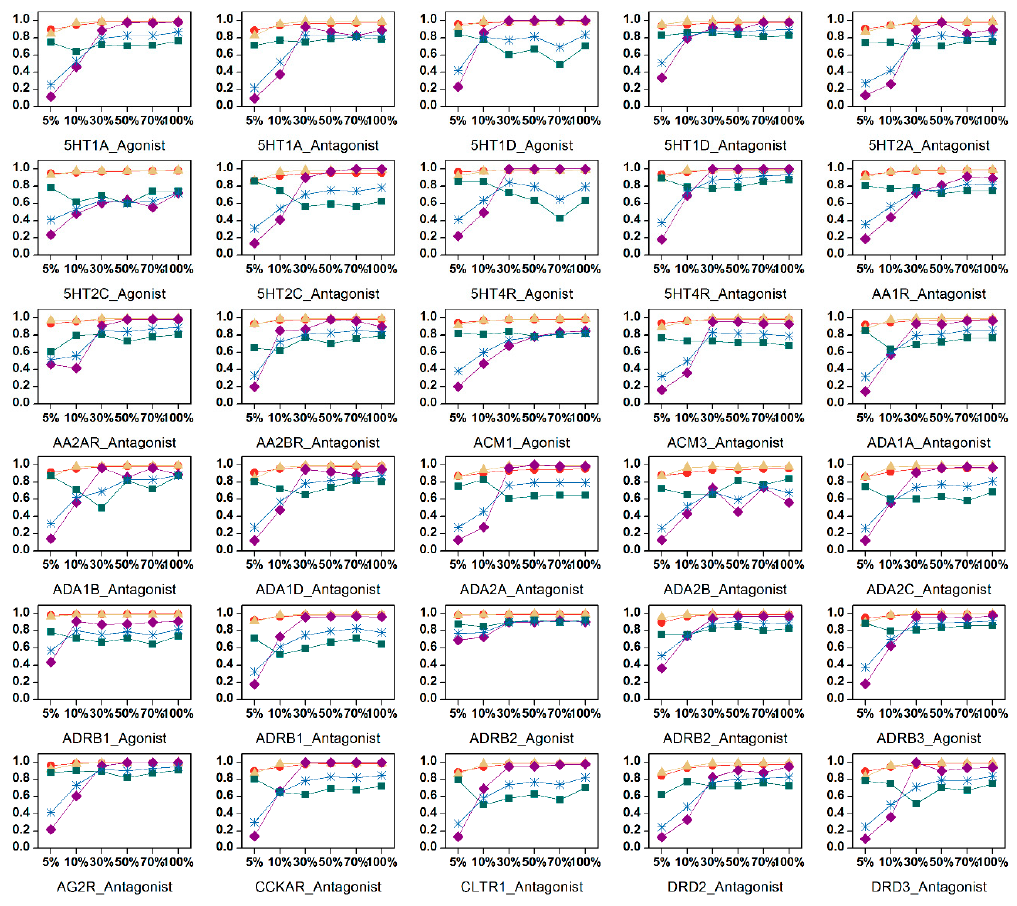
Figure 3. Cont. Figure 3.